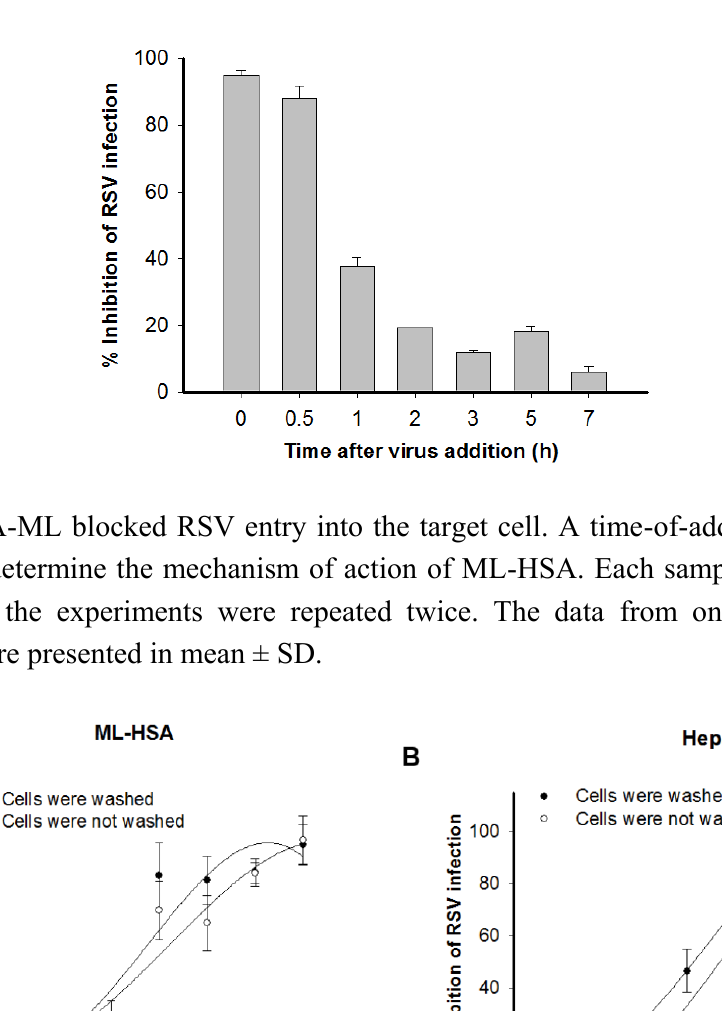
inhibit the formation of syncytia. In contrast, TMC353121 at 200 nM significantly blocked syncytium formation (Figure